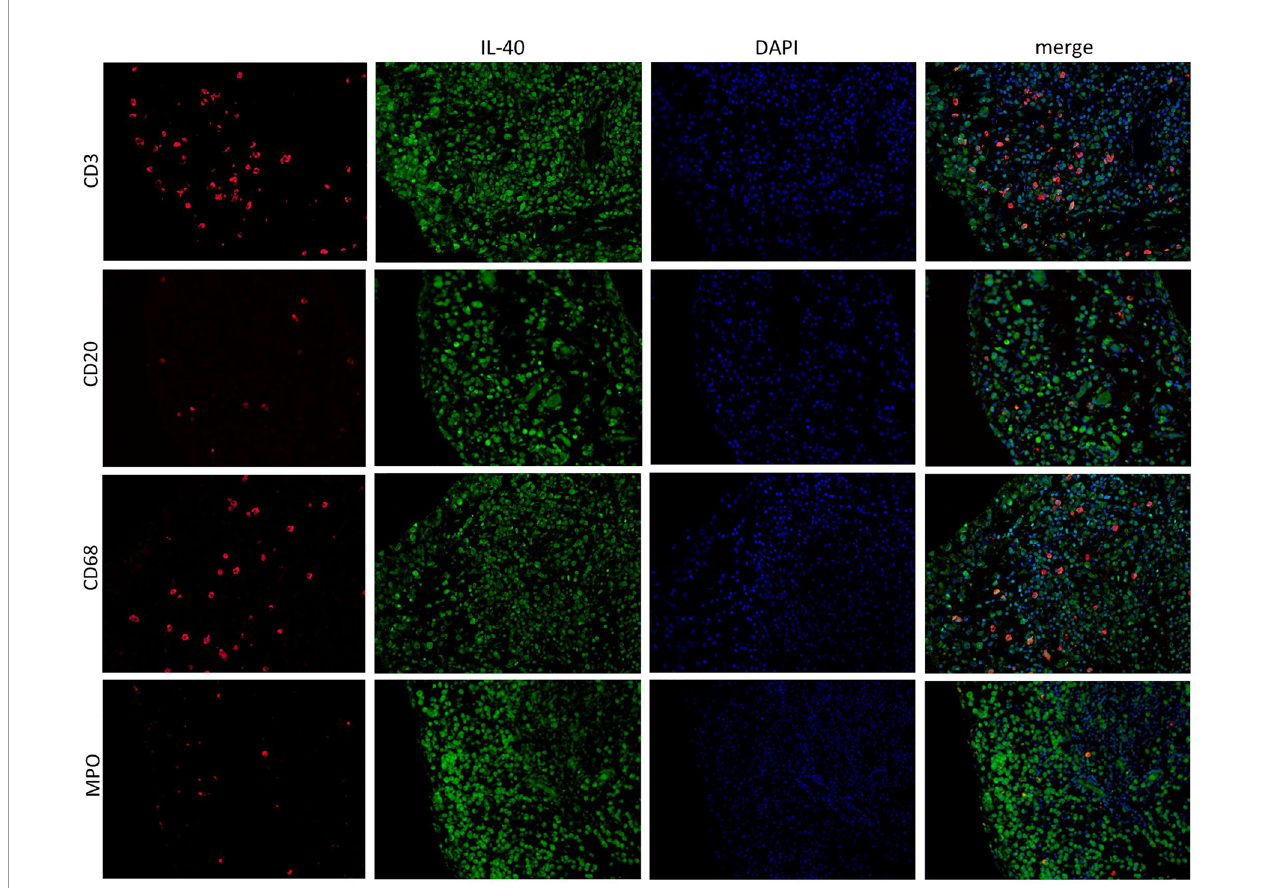
FIGURE 2 | IL-40 is expressed by immune cells in the synovial membrane of patients with rheumatoid arthritis (RA). In addition to the synovial lining, IL-40 positivity (green) was observed in in fi ltrating cells of RA synovial tissue, demonstrated by speci fi c marker staining (red) for T lymphocytes (CD3), B lymphocytes (CD20), macrophages (CD68), and neutrophil myeloperoxidase (MPO). Nuclei were stained by DAPI (blue). Representative images of immuno fl uorescence staining are shown at × 200 magni fi cation (RA, n = 4). DAPI, 4 ’